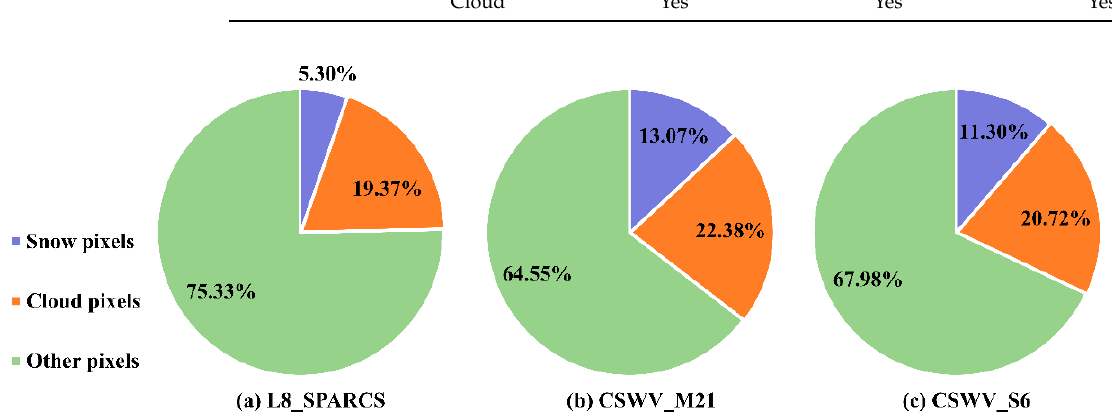
Figure 6. The proportion of cloud, snow, and background pixels in different datasets. ( a ) The components of L8_SPARCS. ( b ) The components of CSWV_M21. ( c ) The components of CSWV_S6.